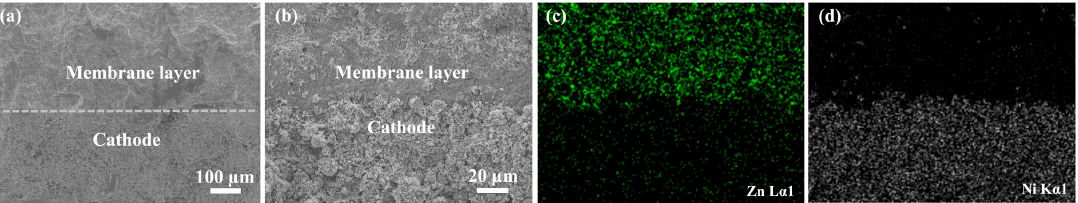
Figure 2. SEM images of ( a ) the resultant ZnO power and ( b ) ZnO-LCP composite; ( c ) Cross-sectional morphology of ZnO-LCP cell; ( d ) NCAL-Ni electrode; ( e ) NCAL particles and ( f ) the intermediate ZnO-LCP layer after operation.